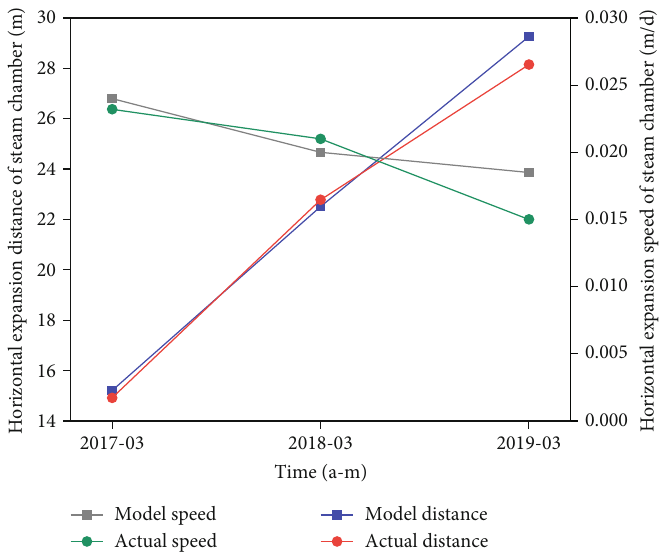
Figure 6: Schematic of the edge and velocity distribution of the steam chamber at di ff erent times.